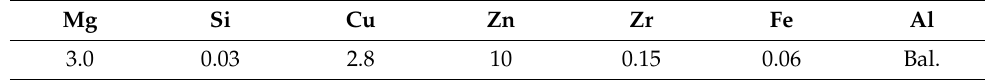
Table 1. Chemical constituents of 7xxx aluminum alloy (wt.%).